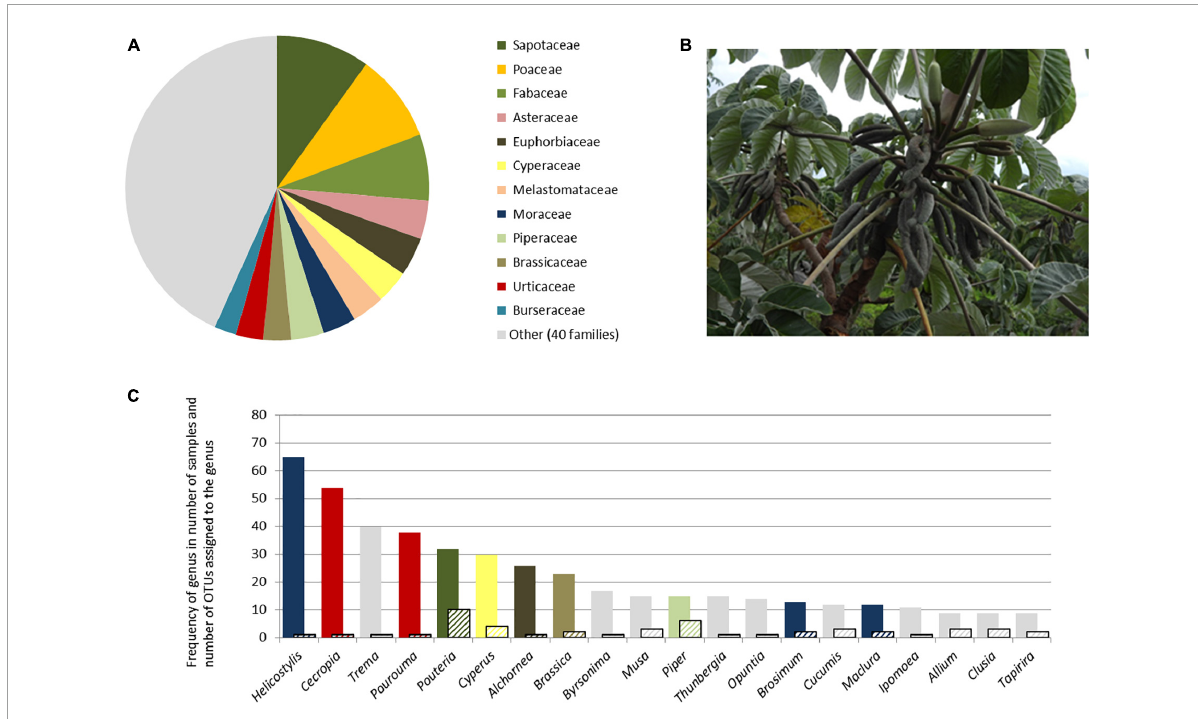
FIGURE3 Overview of the taxonomic identification of plant sequences extracted from air samples taken in Reserva Biológica do Uatumã, Central Amazonia, based on ITS2 target region. (A) Number of OTUs identified per plant family; (B) Cecropia sp., one of the most frequently captured angiosperm genera; (C) frequency of genera in terms of number of samples (colored bars) and number of OTUs assigned to each genus (hatched bars)—column color refers to the family they belong, following (A)